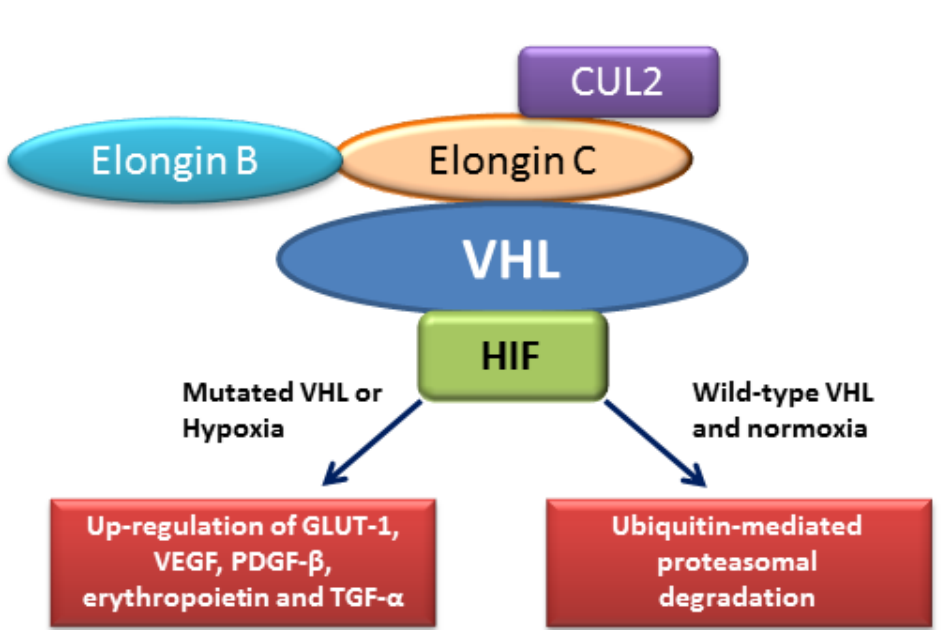
Figure 1. The interaction of VHL protein with HIF and other proteins including elongin B, elongin C and CUL2. A mutated VHL stabilizes HIF and leads to the up-regulation of many pro-angiogenic factors including GLUT-I, VEGF, PDGF-β, erythropoietin and TGF-α. A wild type VHL degrades HIF through ubiquitin-mediated